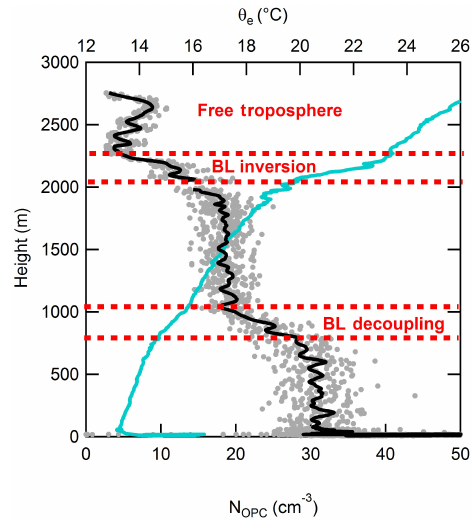
Figure 9. UAV vertical profile of OPC aerosol number concen- trations ( D p >0.3µm; grey) with a 20s running mean (black) and equivalent potential temperature ( θ e , light blue) illustrate decou- pling of the boundary layer. In-cloud OPC measurements (2000– 2050m) have been